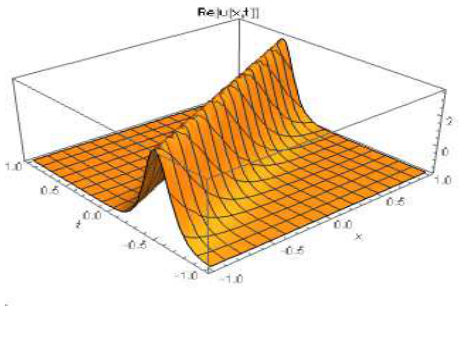
Figure 2. The 3D shape for the real part of Eq. (15) with the values k = 2, c 0 = 1, µ = 3, 5 < t < 5 and t = 0 for the graphic − of 2D.